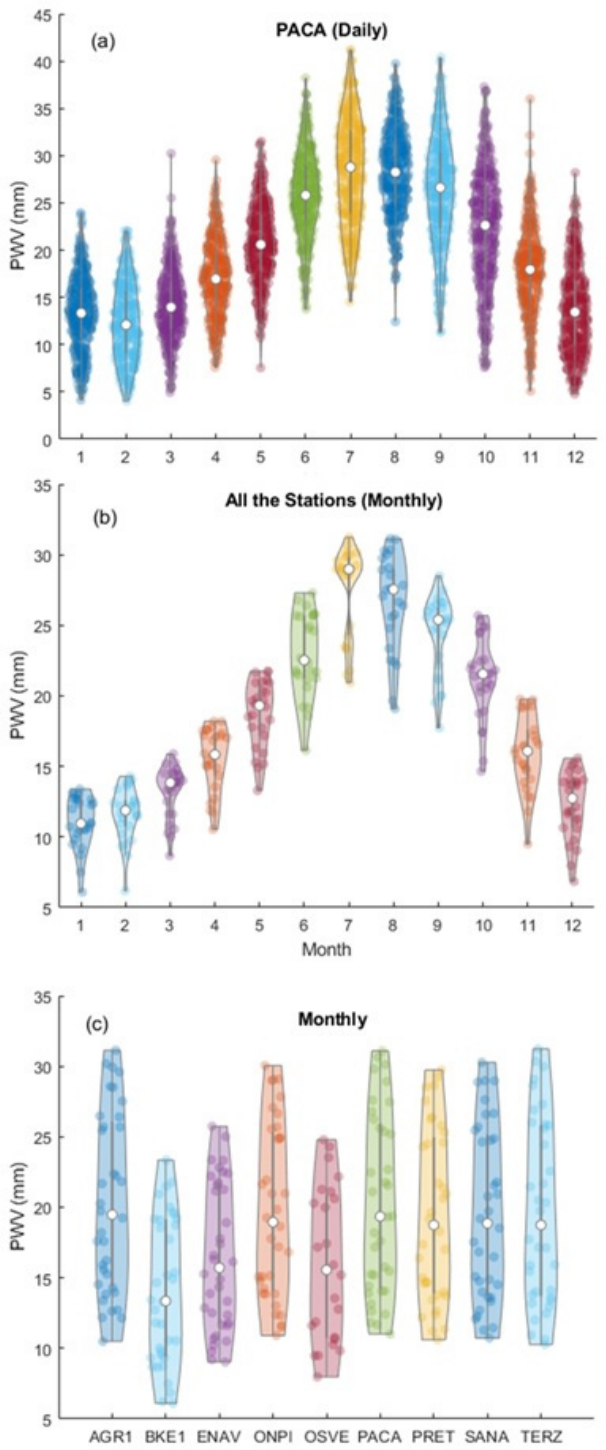
Figure 6. Violin plots for PWV values: ( a ) daily values for PACA site used as an example, ( b , c ) monthly values for several NeVoCGPS sites. Each PWV value is plotted with a kernel density estimate (the violin shaped envelope), where the individual daily/monthly mean values (circles) are also plotted within each shape. The annual cycle ( a , b ) and the variability of PWV with height ( c ) are clearly visible; the white circle indicates the median, the thicker grey bars in the middle of the violin indicate the interquartile range (IQR), the lower/upper adjacent values (the grey lines stretched from the bar)—defined as first quartile − 1.5 IQR and third quartile +1.5 IQR, respectively. Plots have been produced with the Matlab ® code by Bechtold and Bastian